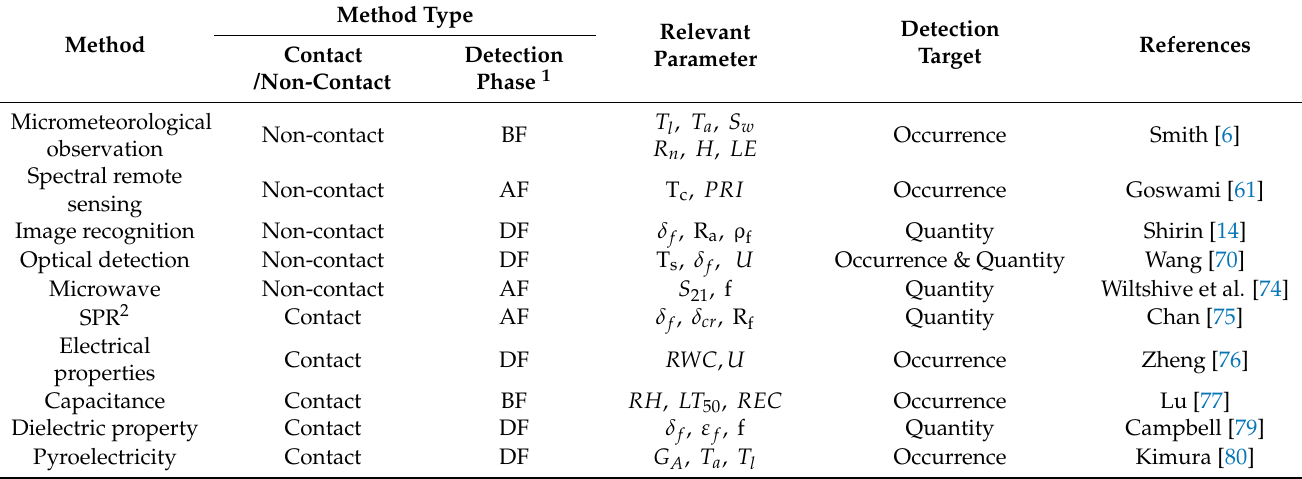
Table 2. Ten methods of frost